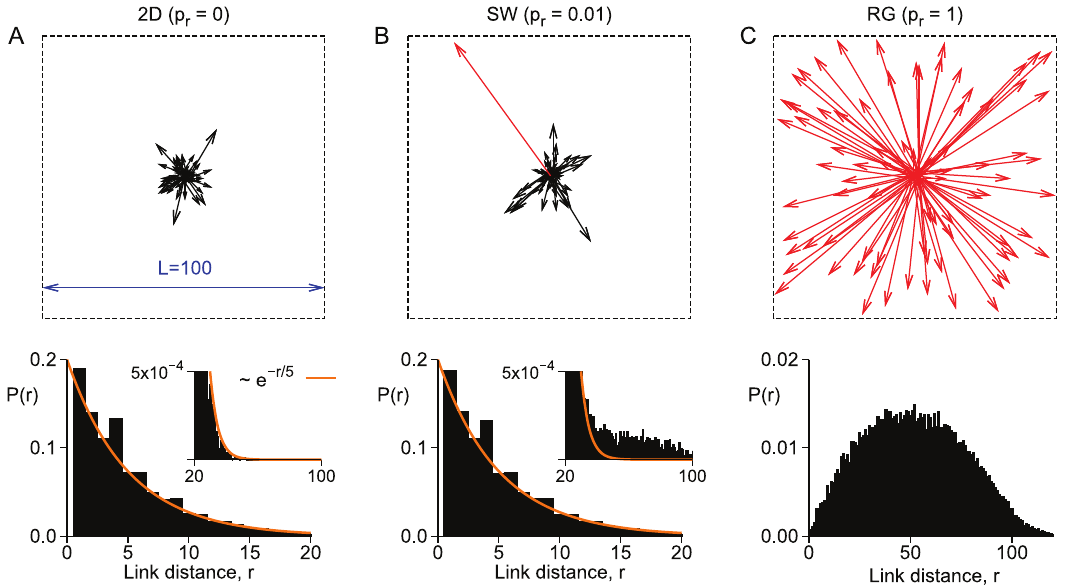
Figure 1. Network topology. Examples of synaptic reach (top) as well as the link size distribution P ( r ) (bottom) for the: A) two-dimensional network; B) small-world network; C) random network. Red arrows in top panels represent synapses which have been rewired ( p r is the rewiring probability). Dashed lines represent the network limits.